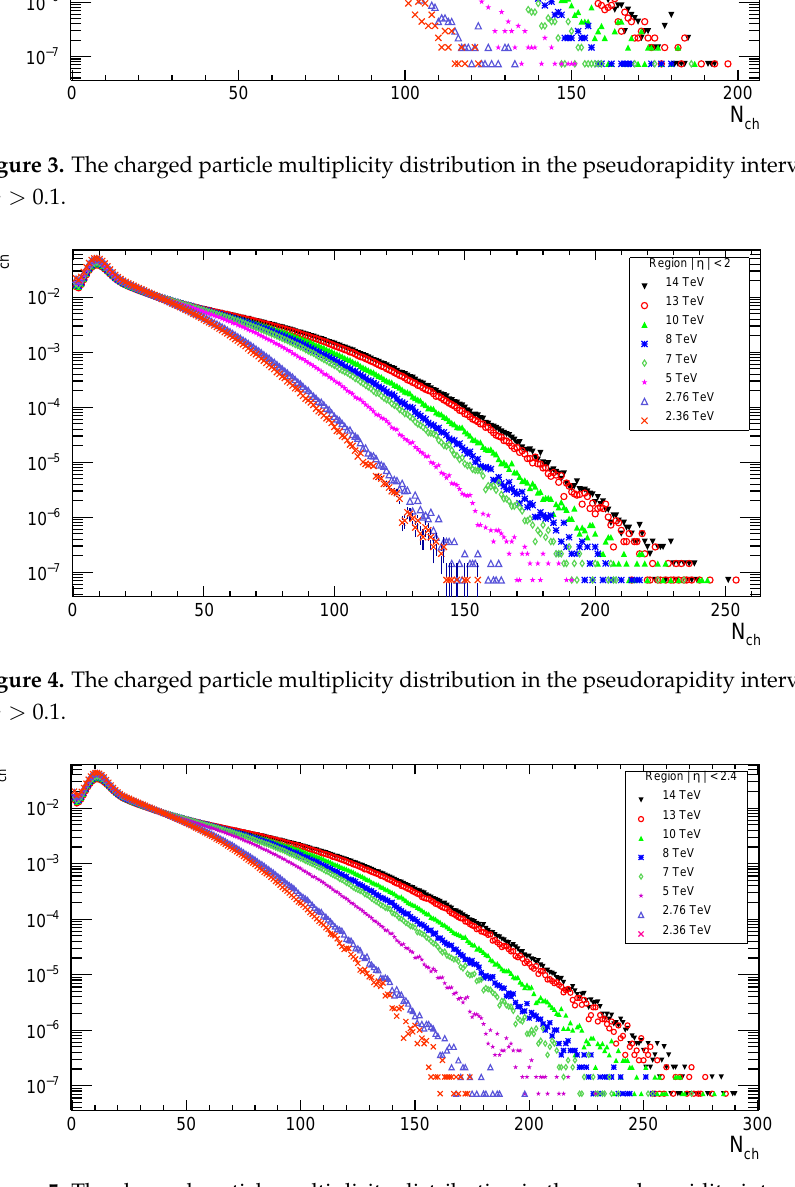
Figure 5. The charged particle multiplicity distribution in the pseudorapidity interval | η | < 2.4, with p T > 0.1